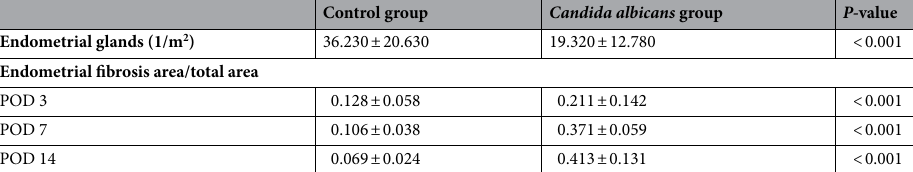
Control group Candida albicans group P-